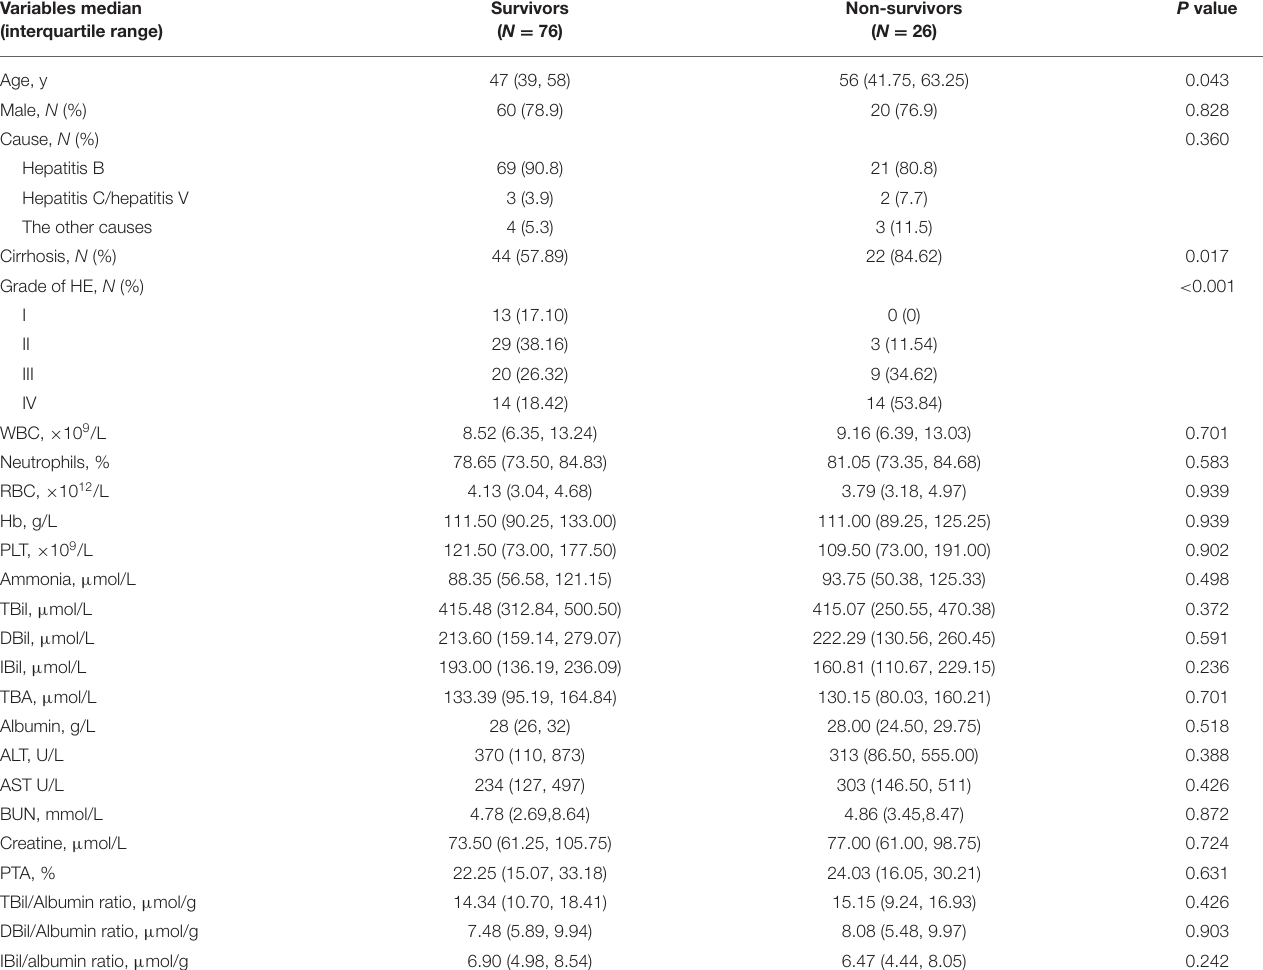
TABLE 2 | Comparison of characteristics of survivors and non-survivors during hospitalization with HE. Variables median (interquartile range)